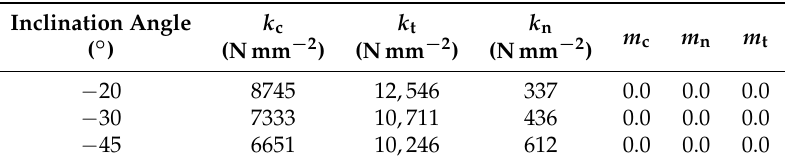
Table 3. Parameter values of cutting force